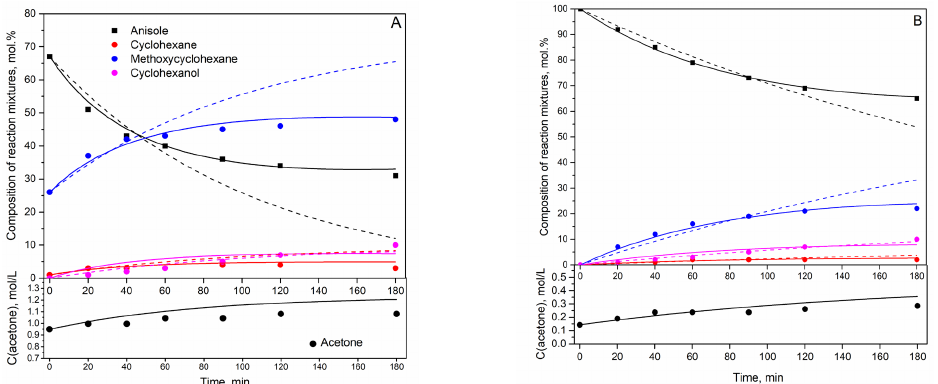
Figure 8. Percentage composition of the reaction mixtures as functions of time obtained over Ni(36)Cu(14)–SiO 2 at ( A ) 250 °C, 7.3–8.1 MPa, and ( B ) 150 °C, 0.8–1.0 MPa; m(catalyst) = 0.10–0.11 g at 250 °C and 0.36–0.37 g at 150 °C. The points present the experimental data and the dash lines were calculated using a quasi-first-order kinetic model. Solid lines—the model taking into account the effect of acetone.